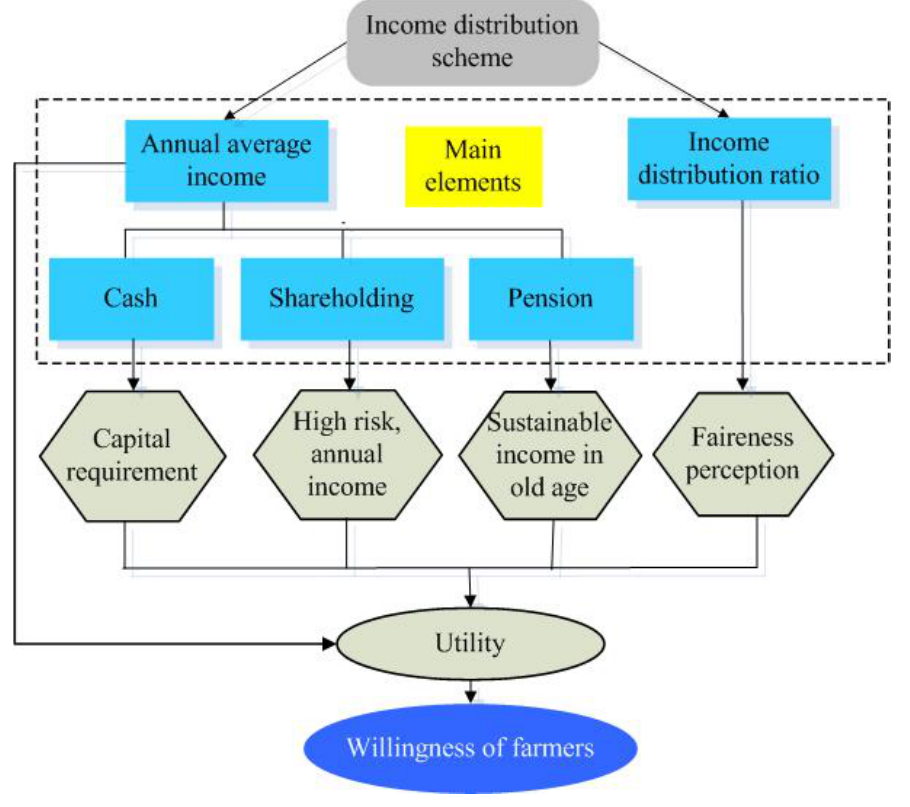
Figure 1. IDS and farmer willingness.